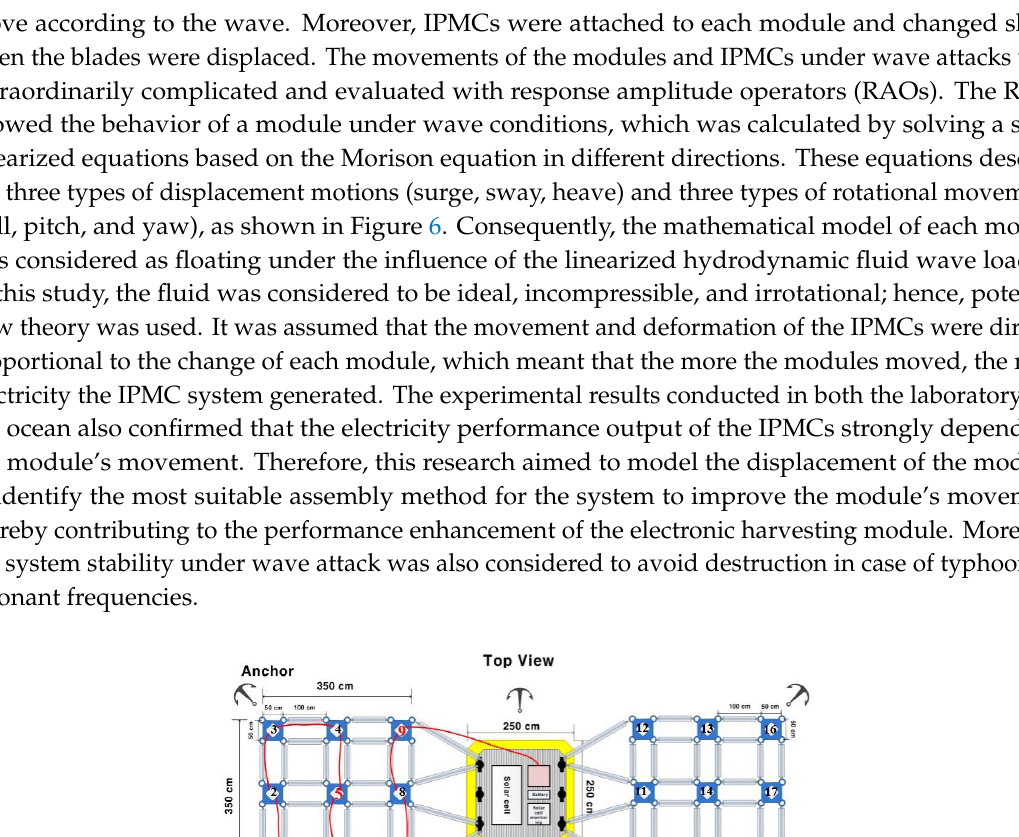
Figure 4. Harvesting energy module: ( a ) rectifying electricity collector connected in parallel to four IPMC-covered electrodes inside a cell, ( b ) total process of fabrication and assembly for a cell, ( c ) the connecting device, and ( d ) the main buoy and the components of an electricity collector .